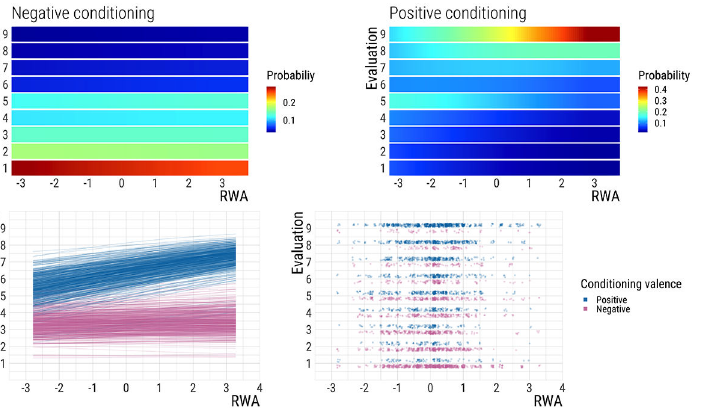
Note. Top: Evaluation of stimuli after conditioning as a function of RWA and conditioning valence: negative (left) vs. positive (right). Based on the estimation given by the ordinal model. Correct graphical representation of the output of the model. Bottom left: Evaluation of stimuli after conditioning as a function of RWA and conditioning valence. Based on the estimation given by the ordinal model but adapted as a linear representation. This representation is simply given to permit familiarity but does not rigorously represent the ordinal nature of the model. The lines correspond to randomly sampled. credible regression lines. Bottom right: Distribution of the data points.